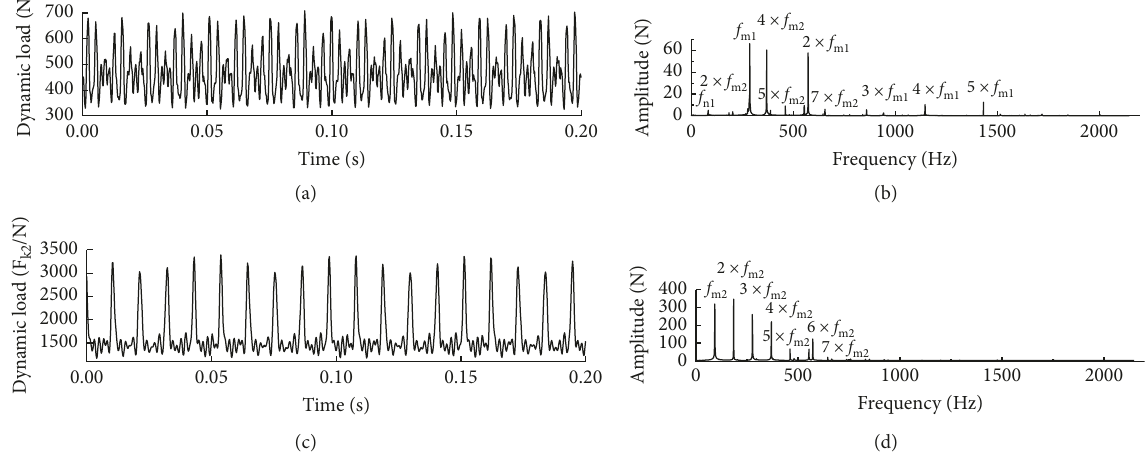
Figure 13: Dynamic load of the two-stage gear transmission system with stiff shaft. Dynamic load time history of (a) the first gear and (c) the second gear. Dynamic load spectrum history of (b) the first gear and (d) the second